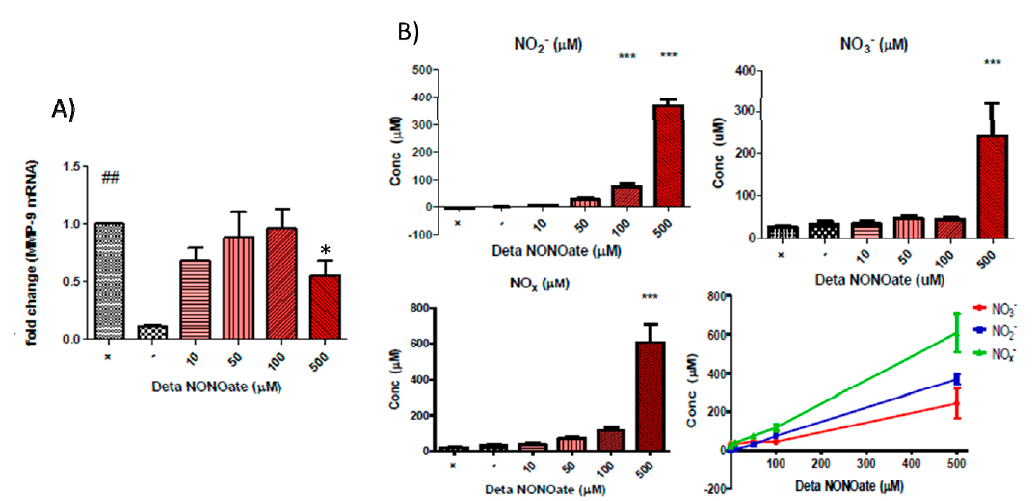
Figure 3. ( A ) DETA NONOate significantly reduced MMP-9 mRNA at high concentrations in cytokine-stimulated Caco-2 cells (## p < 0.01 vs. unstimulated Caco-2 cells (negative control); * p < 0.05 vs. cytokine-stimulated Caco-2 cells (positive control). ( B ) Measurements of nitrate and nitrite concentrations as breakdown products of NO by the Griess assay on the conditioned media of Caco-2 cells after 24 h of co-incubation with DETA-NONOate and pro-inflammatory cytokines TNF- α and IL-1 β . Top left pane shows the nitrite concentration, top right panel shows the nitrate concentration, bottom left pane shows the combined reduced NO groups and bottom right shows the linear correlations of DETA-NONOate concentrations versus the concentration of measured NOx − species (*** p < 0.001 vs negative control).